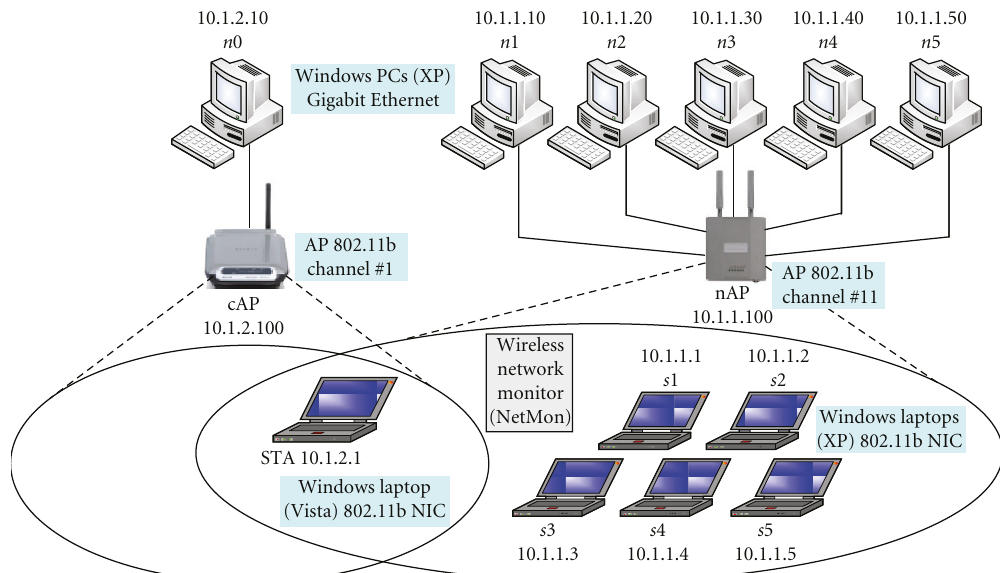
Figure 8: Experiment environment for throughput measurement with